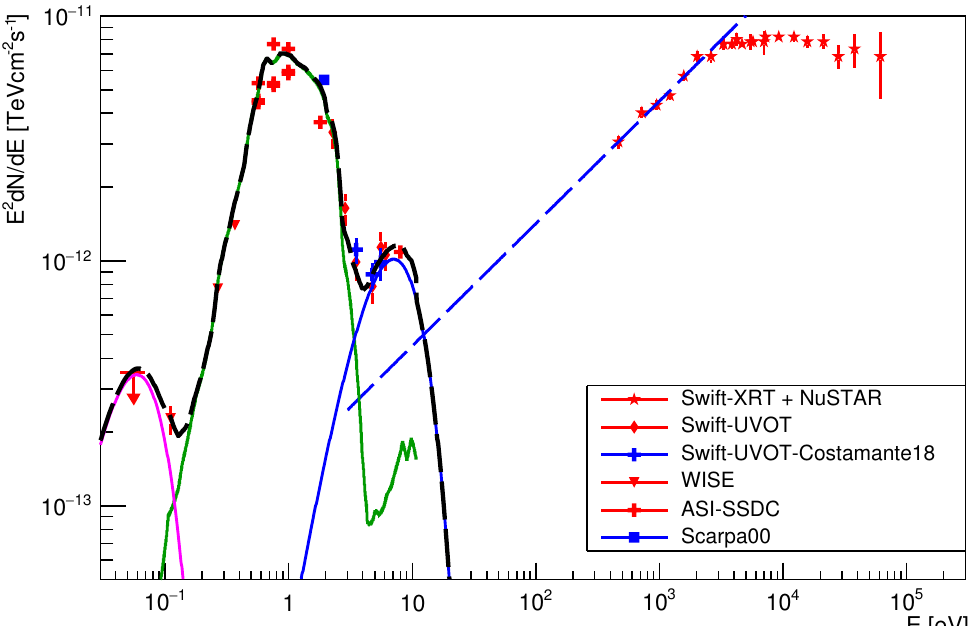
Figure 1. The low-energy part of the SED for 1ES 0229+200 observed with various telescopes. Red stars denote X-ray measurements, red and blue symbols of other shapes—optical, UV, and IR measurements. Green solid curve denotes the giant elliptical galaxy template of S98, blue solid curve— the blackbody component peaking in the UV energy range, magenta solid curve—the blackbody component peaking in the IR energy range, thick dashed black curve—the sum of the latter three components. Dashed blue line denotes a low-energy extrapolation of the X-ray component. Red arrow denotes an upper